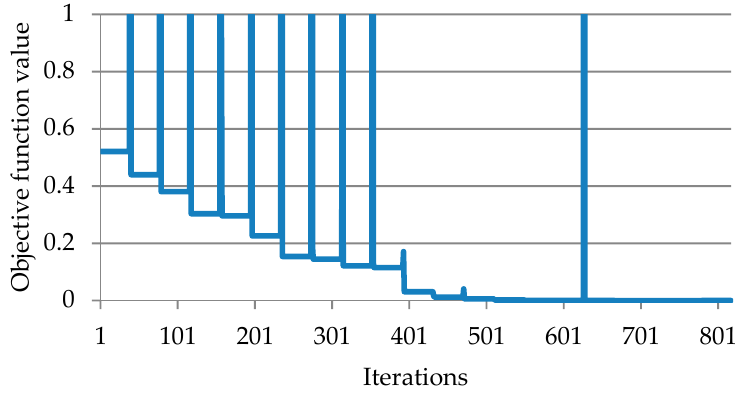
Figure 3. Objective function value at each optimization iterations (case 1).